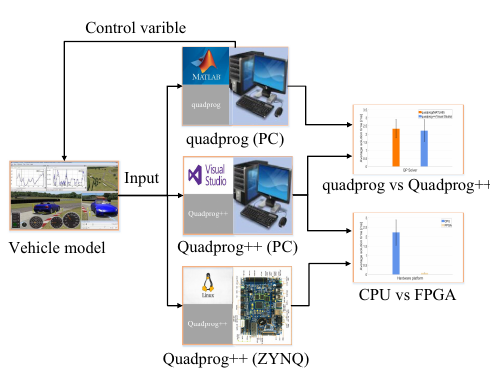
Figure 6 Veri fi cation scheme